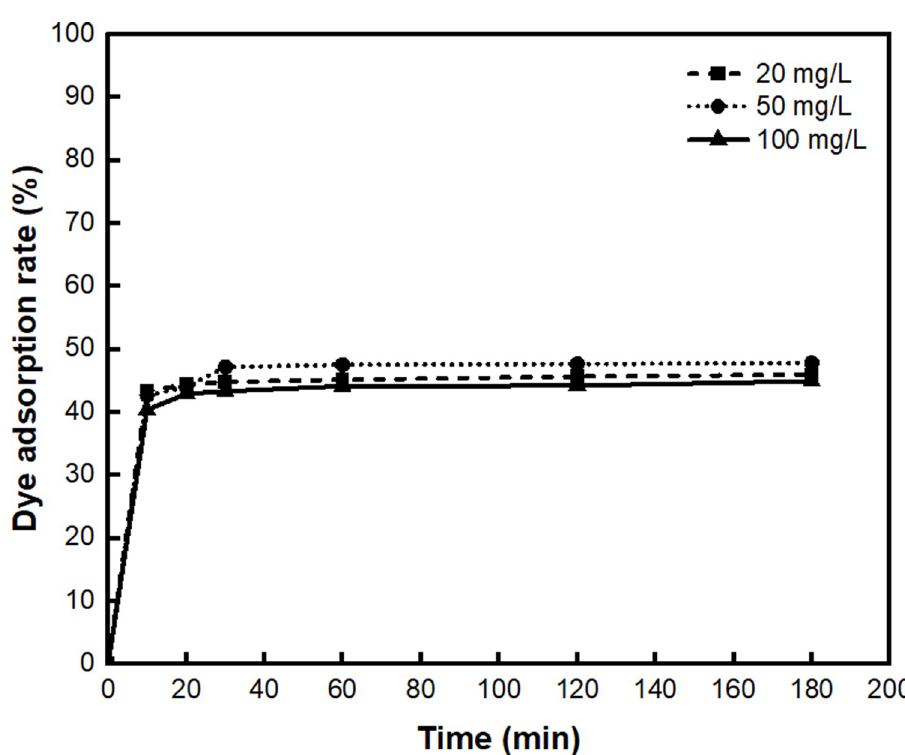
Fig 8. Dye adsorption rate (%) of BC-COF bio-leather with varied treatment time and concentration of the methylene blue solution (Extraction conditions: Liquor ratio of 1:10 (w/v), coffee at an amount of 200 wt% BC, 90˚C, 1 h; dyeing conditions: Fabric-to-liquor ratio of 1:10 (w/v), 70˚C, 30 min, meta-mordanting with 1% of FeSO 4 ; dye adsorption conditions: Fabric-to-liquor ratio of 1:200 (w/v), 25˚C).